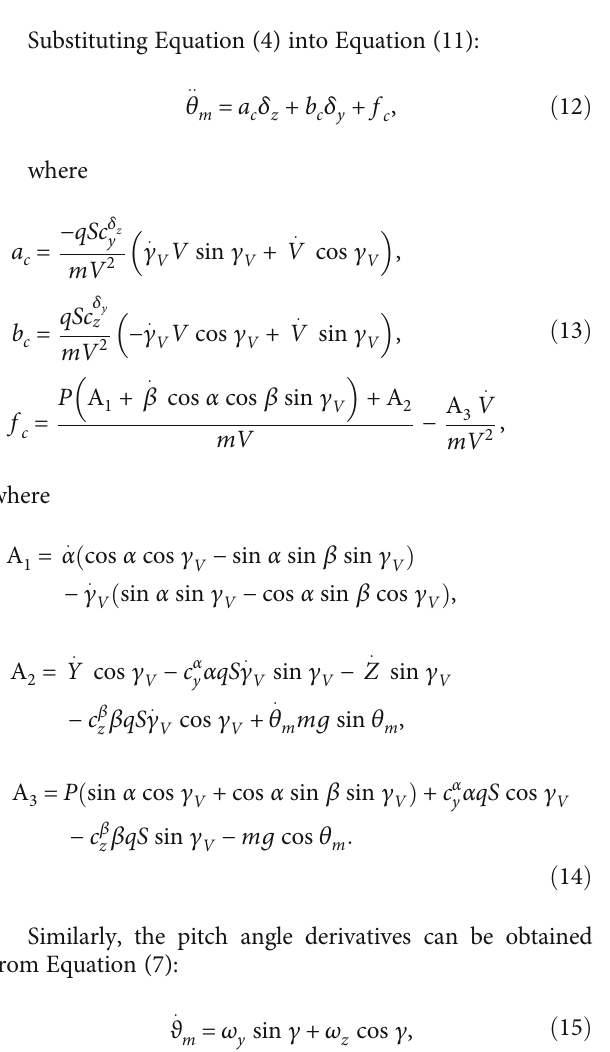
Figure 3: Arctangent function